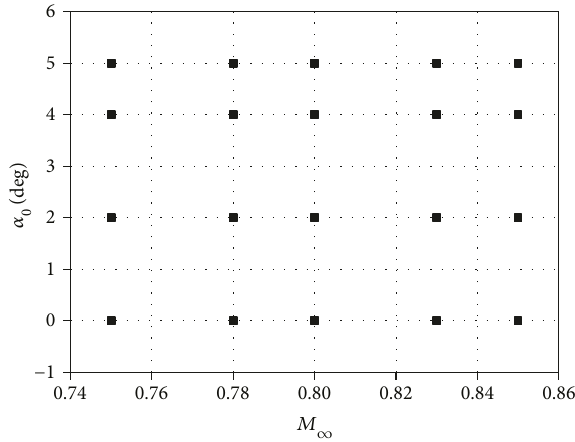
Figure 7: The training data validation of a NACA 64A010 airfoil at M α = 1 deg ∞ = 0 76 and 0